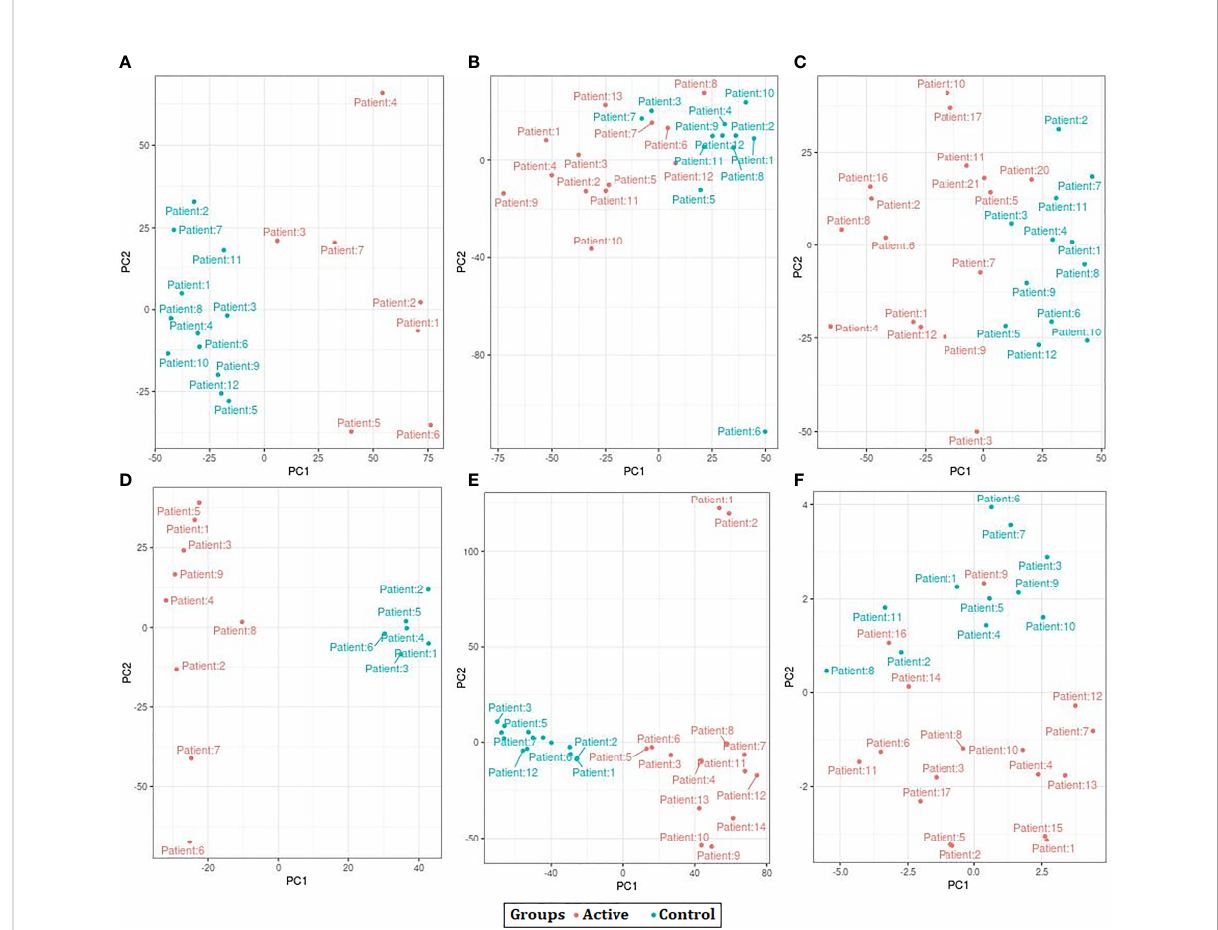
FIGURE 2 Principal Component Analysis (PCA) plots showing the separation control and active samples across all datasets used in the study. (A) GSE19435 (B) GSE19439 (C) GSE19444 (D) GSE54992 (E) GSE62525 (F)